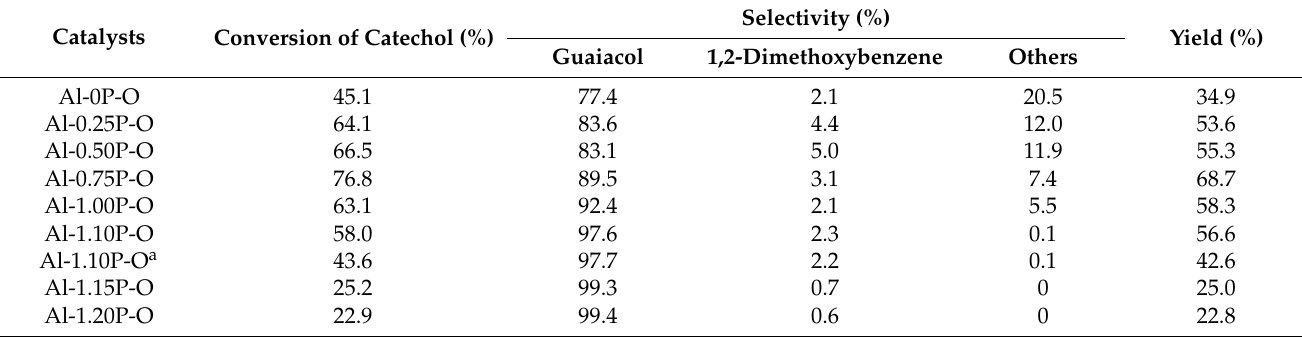
Table 2. Catalytic performance of Al- x P-O and Al-1.1P-O a